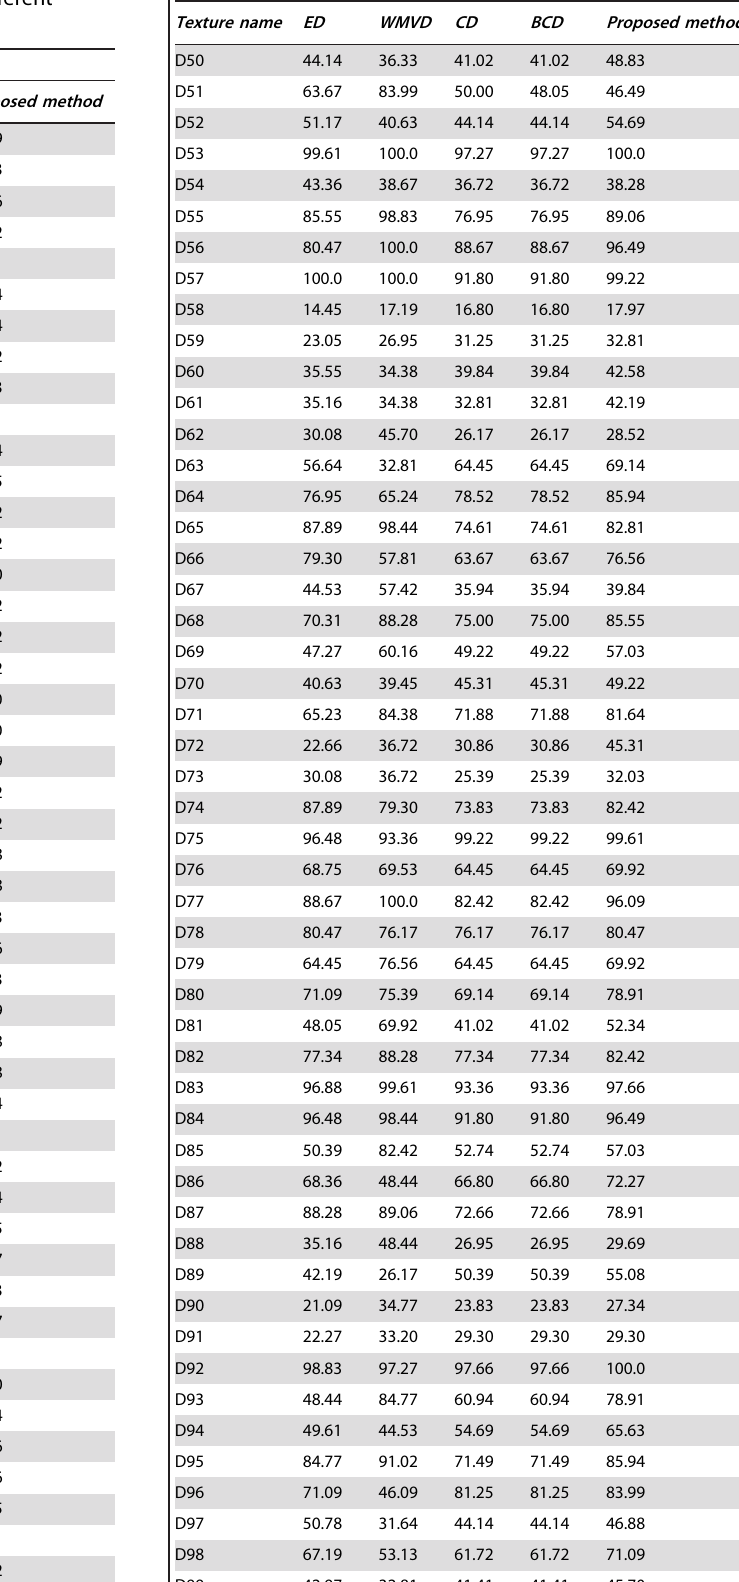
Table 3. Comparison of retrieval performance of different types of metrics for texture image retrieval using NSCT on the Brodatz image database (1776 images of 111 different